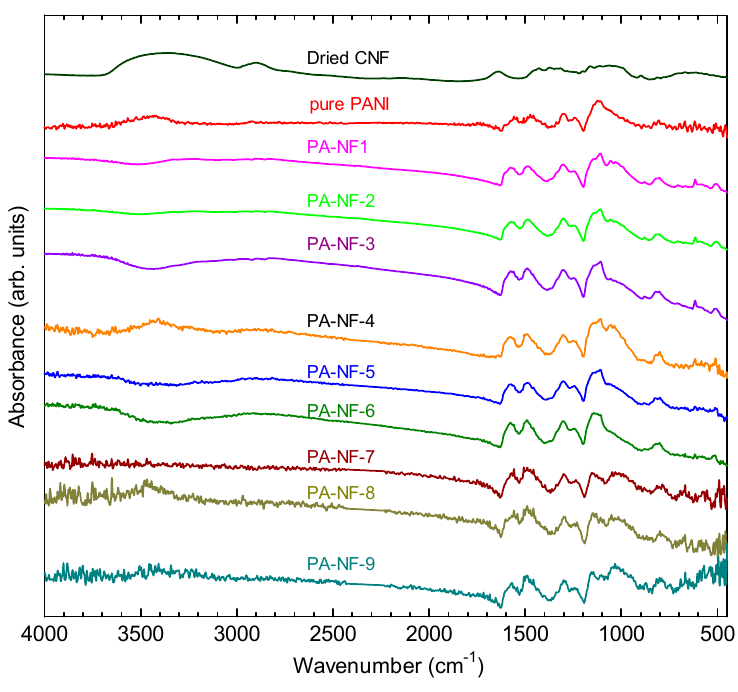
Figure 1. Fourier transform infrared (FTIR) spectra of dried CNF, pure PANI, and PA-NF1, PA-NF2, PA-NF3, PA-NF4, PA-NF5, PA-NF6, PA-NF7, PA-NF8, and PA-NF9.